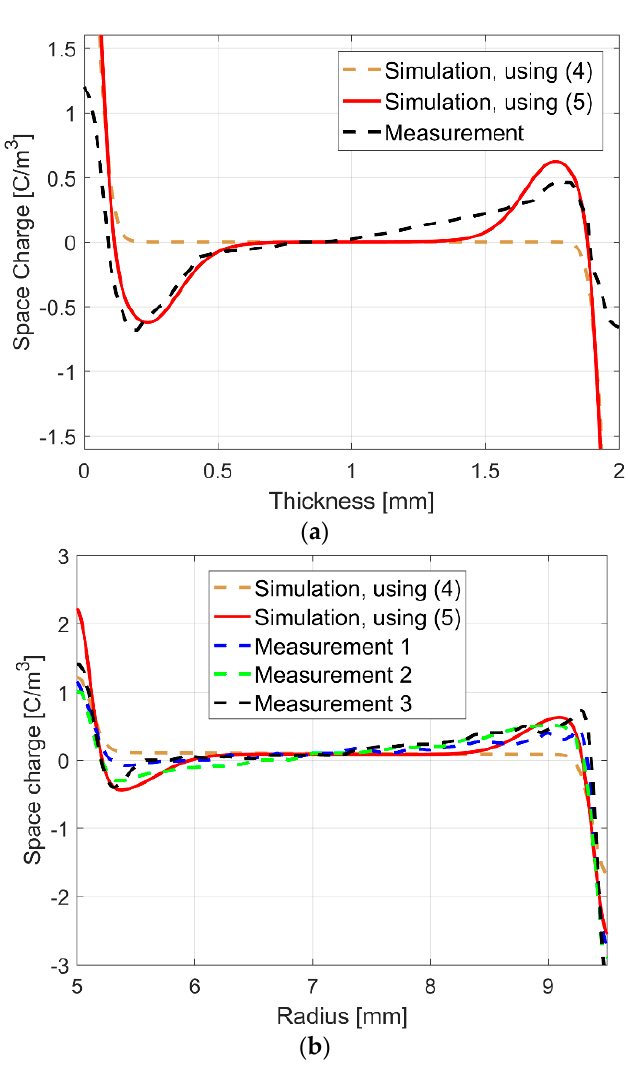
Figure 6. Measured and simulated charge distribution in a XLPE and LDPE insulation [6]. ( a ) XLPE, planplanar, + U ; ( b ) XLPE, planplanar, − U ; ( c ) XLPE, cylindrical, + U ; ( d ) XLPE, cylindrical, − U ; ( e ) LDPE, planplanar, + U ; ( f ) LDPE, planplanar, − U . The absolute value of the applied voltage is | U | = 20 kV.